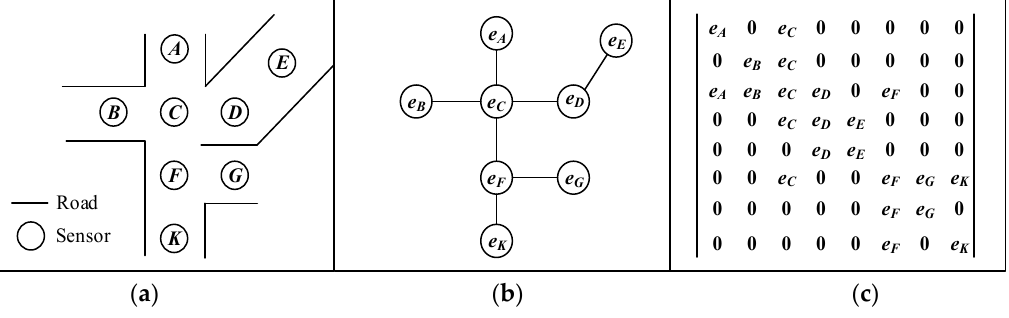
Figure 1. Definition of the geographical sensor network. ( a ) Geographic Secsor Distribution; ( b ) Geographic Secsor Network; ( c ) Adjacent matrix M .